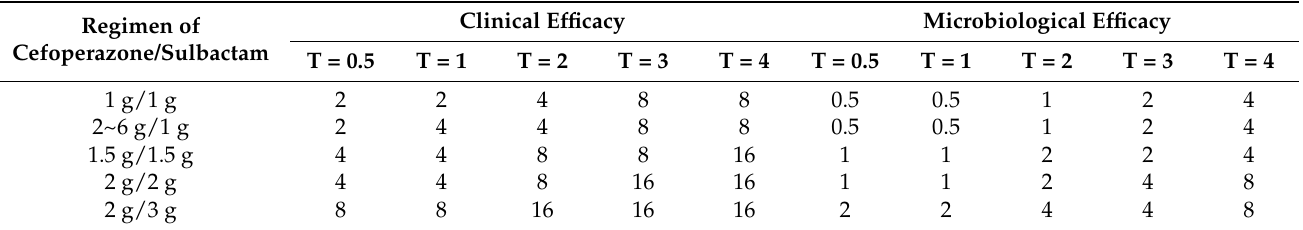
Table 6. PK/PD cutoff based on %(T > MIC cpz *T > MIC sul ) against Ab (mg/L). Dosing frequency was